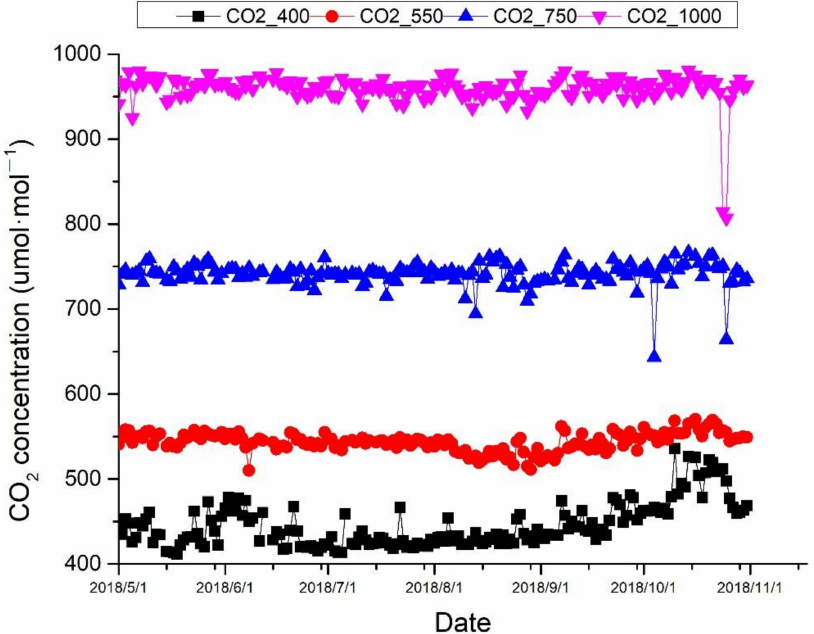
Figure 4. The actual CO 2 concentration at different treatments during the growth